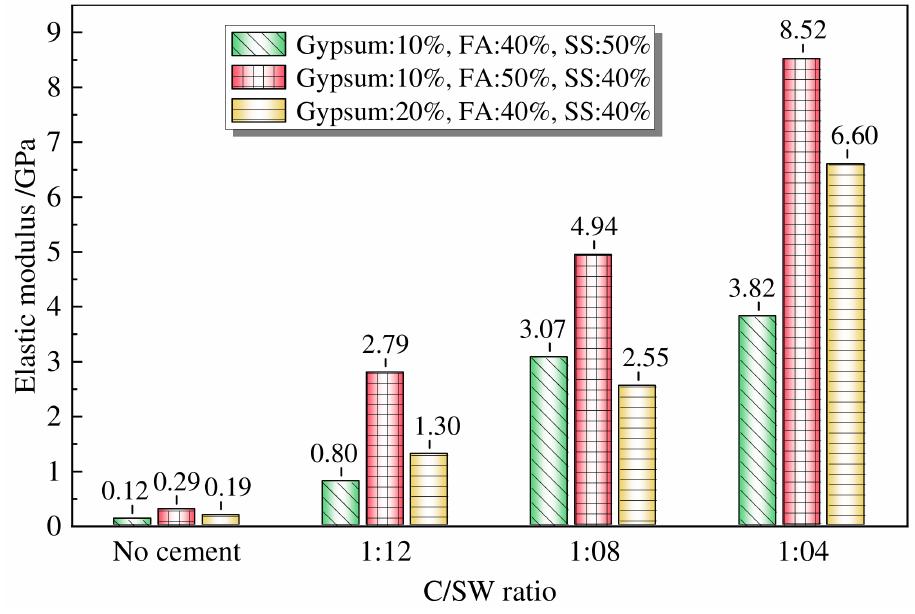
Figure 5. The power fitting relationship between the elastic modulus and C/SW